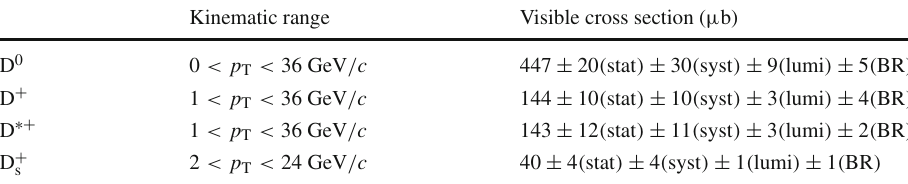
Table 3 Ratios of the measured p T -integrated cross sections of prompt D mesons in | y | < 0 . 5 in pp collisions at Kinematic range Production cross section